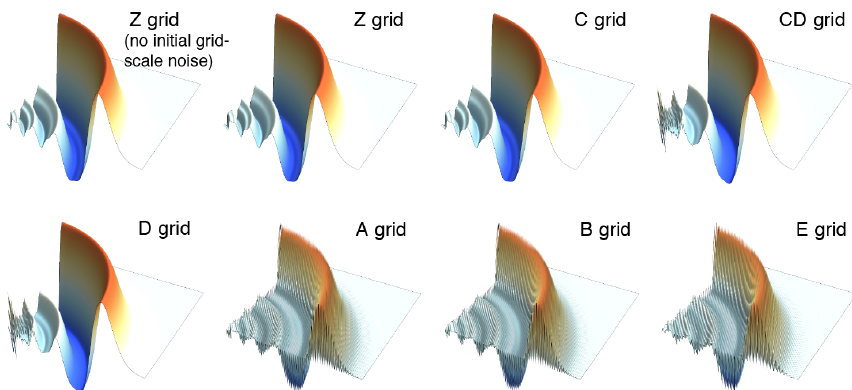
Figure 13. Horizontal structure of the inertia–gravity wave simulated by the various horizontal grids after 100min of integration.